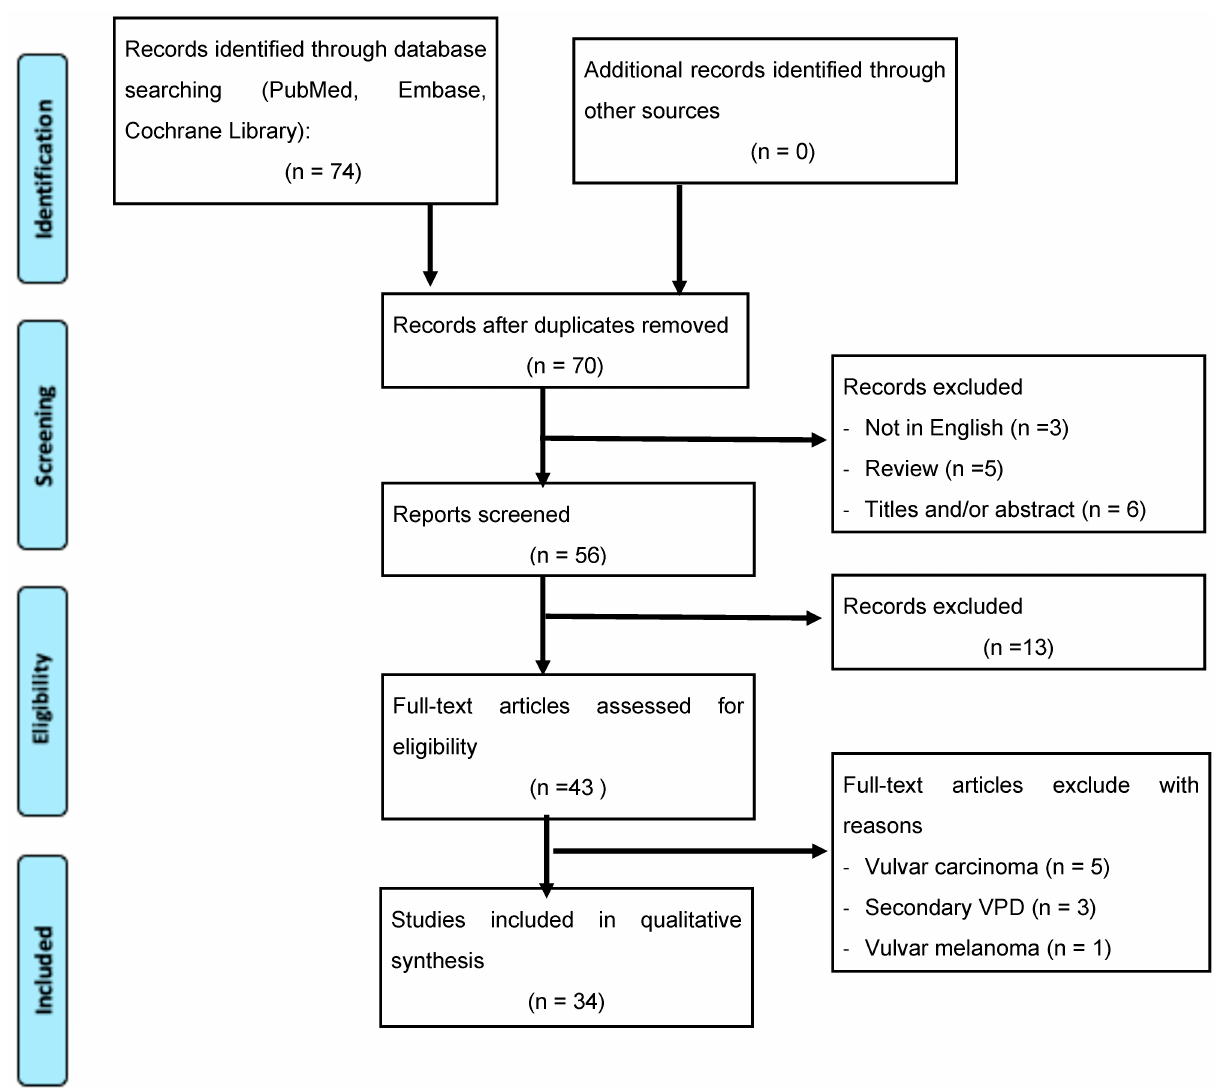
Figure 1. Flowchart of systematic review search.